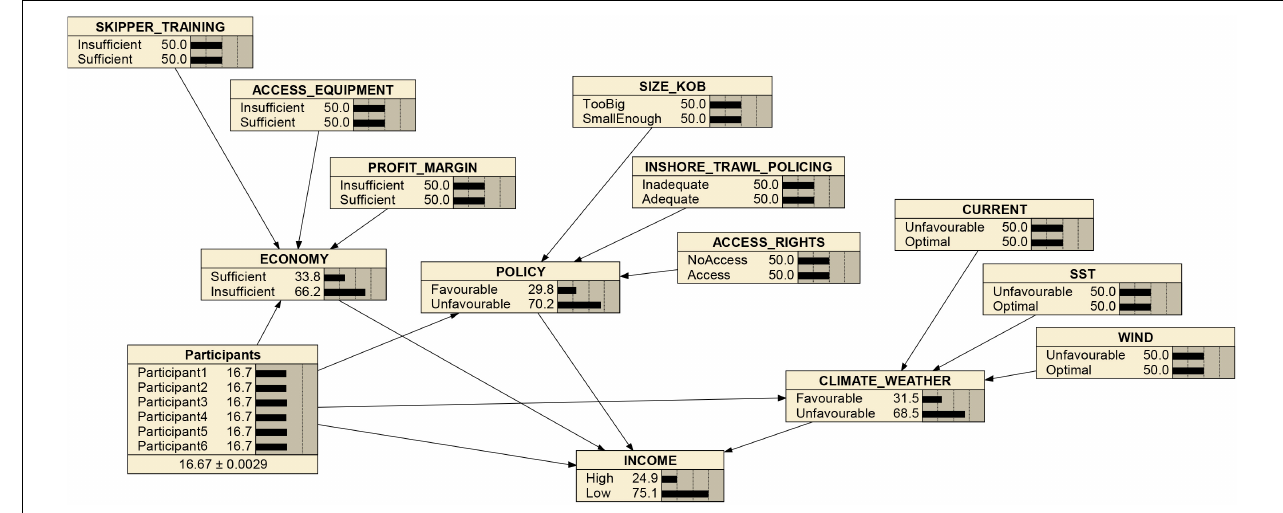
FIGURE 6 | Modelled probability outputs of six BBNs. Each participants’ set of CPTs is integrated into the BBN with an auxiliary node ‘Participants.’